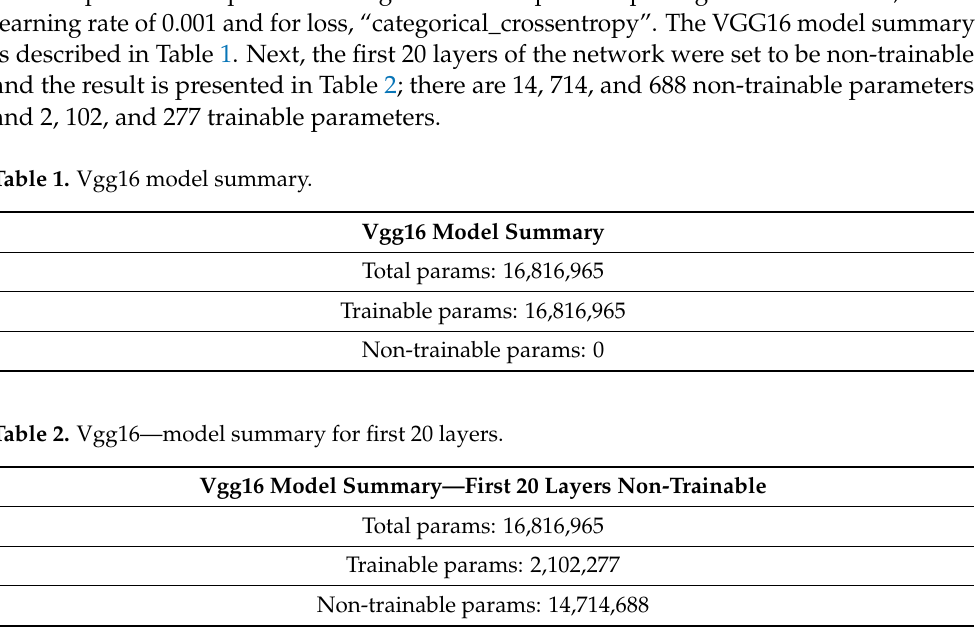
Table 1. Vgg16 model summary.